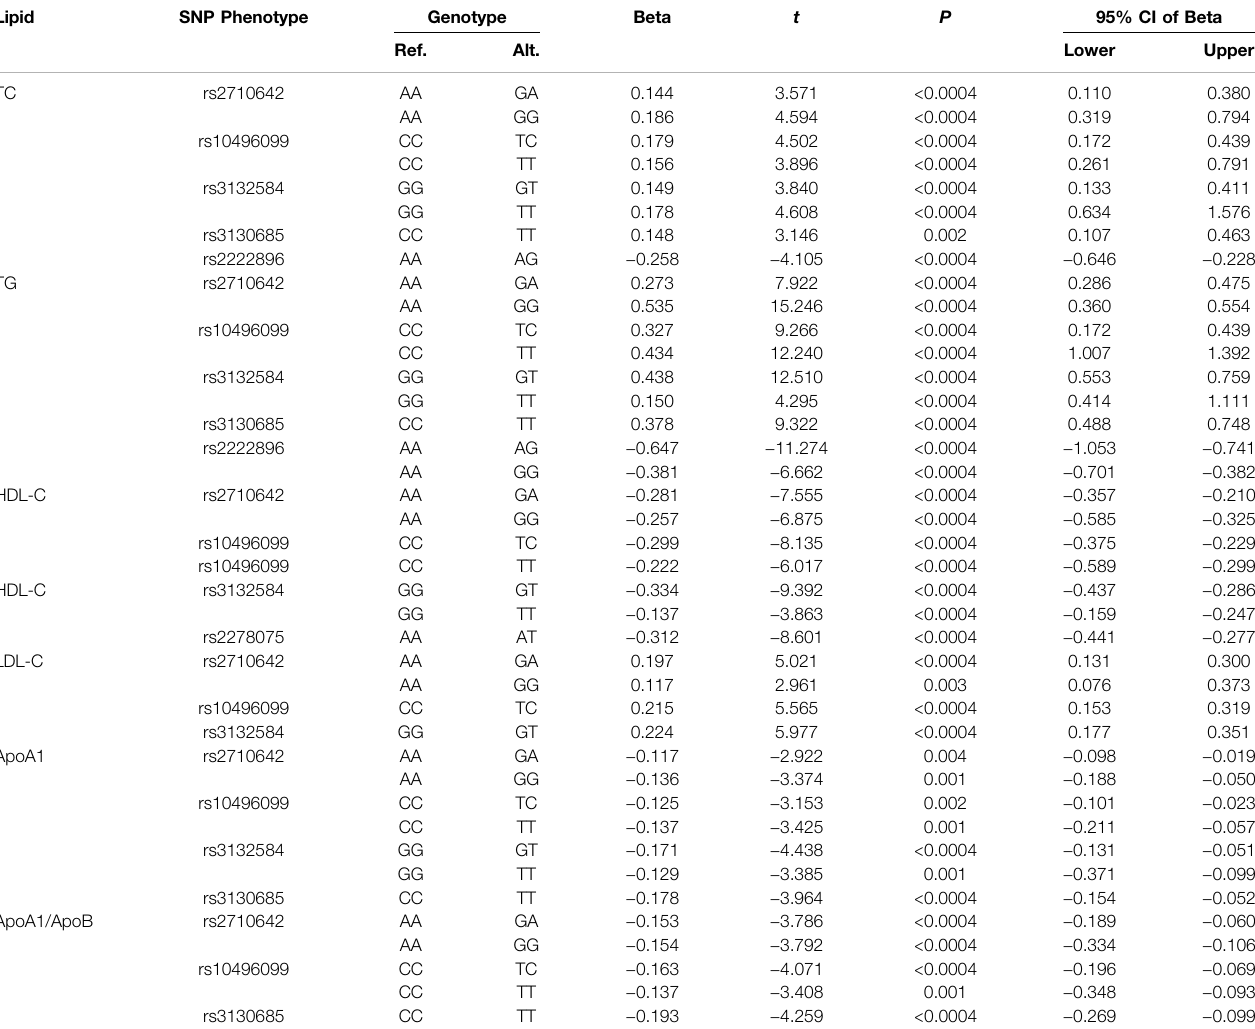
TABLE 4 | Meaningful associations between the SNPs and serum lipid levels in the control group.